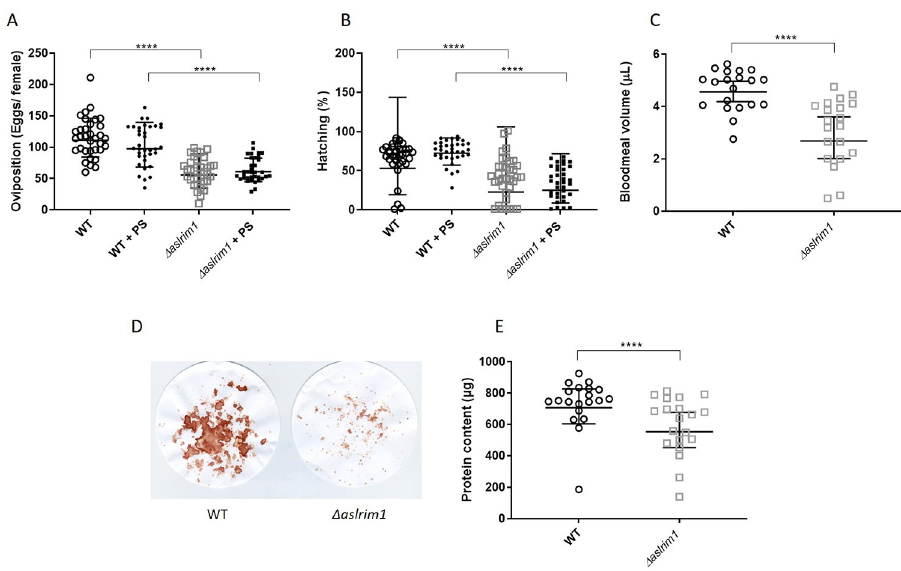
Fig 3. Fecundity in WT and Δ aslrim1 mosquitoes. (A) Number of eggs/ female. The number of eggs was determined by counting the eggs laid in single Drosophila tubes. The results are expressed as the geometric mean of the number of eggs/female ± SD; n = 34 for WT and 35 for the other 3 treatments. (B) Percentage of eggs hatching. The hatching was determined by counting the number hatching larvae in the single Drosophila tubes by microscopy, 2 days after egg laying. The percentage is of the total number of eggs laid in that tube (Panel A). The results are reported as the geometric mean of the percent hatching ± SD; n = 34 for WT and 35 for the other 3 treatments. Since some values were zero, a value of 1 was added to the entire dataset to allow calculation of the geometric means. (A and B) The data were analyzed by Kruskal-Wallis and Dunn’s multiple comparisons tests. ���� p � 0.0001. (C) The bloodmeal volumes in WT and Δ aslrim1 mosquitoes immediately after blood feeding. The results represent the geometric mean of bloodmeal volumes ± SD; n = 20. (D) Remnants of blood on the filter paper after blood feeding of 50 females, as an indication of prediuresis. (E) Bloodmeal protein contents in midguts of WT and Δ aslrim1 mosquitoes, immediately after blood feeding. The protein contents were determined using Lowry protein assay. The results represent the geometric mean of midgut protein contents in micrograms ± SD; n = 20. (C and E) The results were analyzed using non-parametric, Mann Whitney test. �� P � 0.01, ���� P � 0.0001.